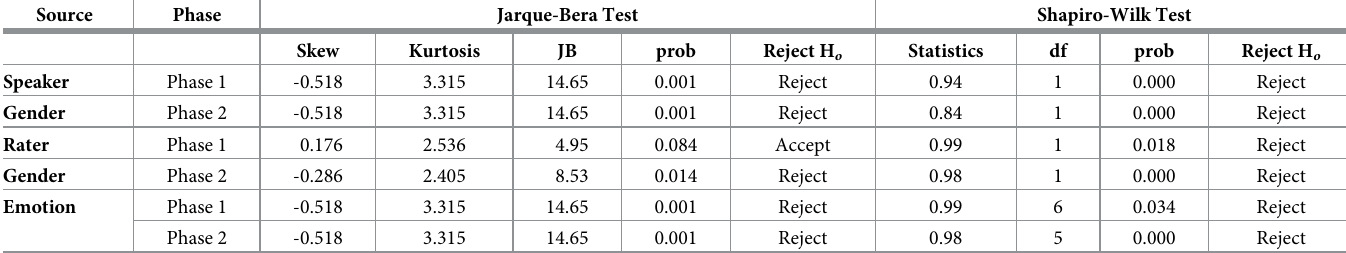
Table 12. Normality statistics tests for emotion and gender-wise data.